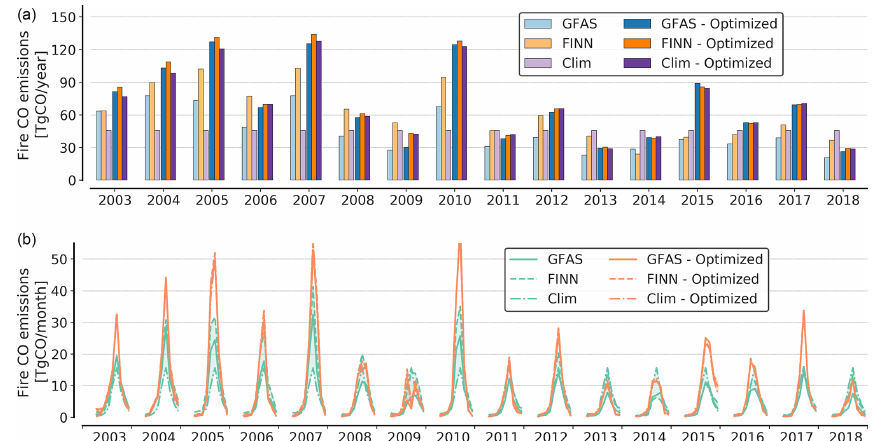
Figure 2. Prior and posterior fire CO emission estimates summed over the 1 ◦ × 1 ◦ South American zoom domain (see Fig. 1). Panel (a) presents the May–December total emissions per year. Panel (b) shows the monthly total emissions, with the colours distinguishing prior (green) from posterior (orange) and the line style indicating the prior used. Shaded areas mark the spread between the three priors and the three posteriors respectively. Note that the posterior estimates mostly overlap; thus, these are visible as one line only.